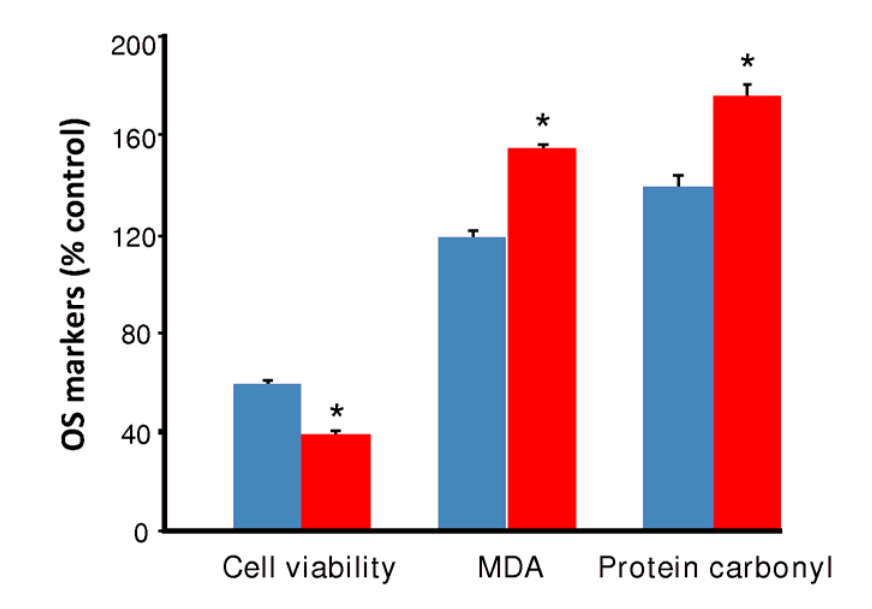
Figure 2. Oxidative stress (OS) markers on HT-22 cells after 24-h ethanol (EtOH, 100 mM) exposure and subsequent 4-h ethanol withdrawal (EW). In control experiments (vehicle only) cell viability was counted as 100%, MDA level was 173 ± 6.5 nmol/mg protein and protein carbonyl content was 1.28 ± 0.01 nmol/mg protein. Data are given as mean ± S.E.M. for n=4. Both ethanol exposure ( ) and EW ( ), produced a statistically significant difference (p<0.001) in OS markers from those measured in control experiments. Asterisk indicates a significant difference (p<0.01) between EW vs EtOH exposure